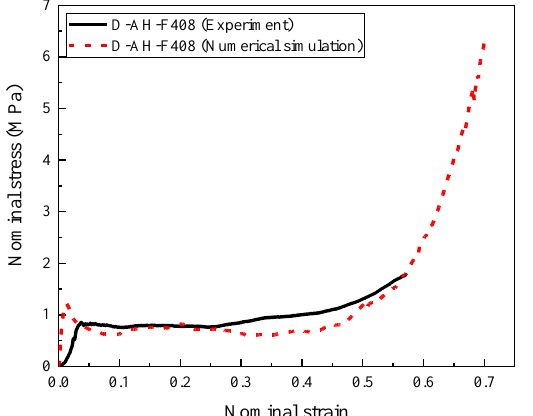
Figure 9. The measured and simulated stress – strain relationships of the auxetic honeycomb filled